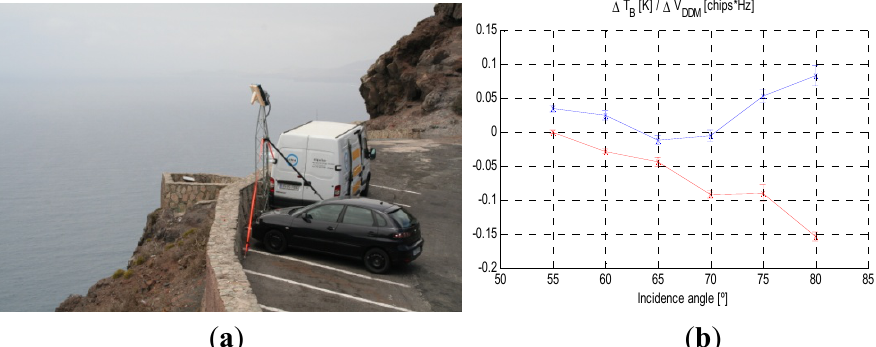
Figure 19. ( a ) griPAU instrument deployed in a 380 m cliff in the North coast of Gran Canaria; ( b ) Estimated brightness temperature sensitivity to changes in the normalized DDM volume at vertical (red) and horizontal (blue) polarizations respectively. Values at H-pol and θ = 65° and 70° are probably erroneous due to reflections in the cliff (from [77]). i